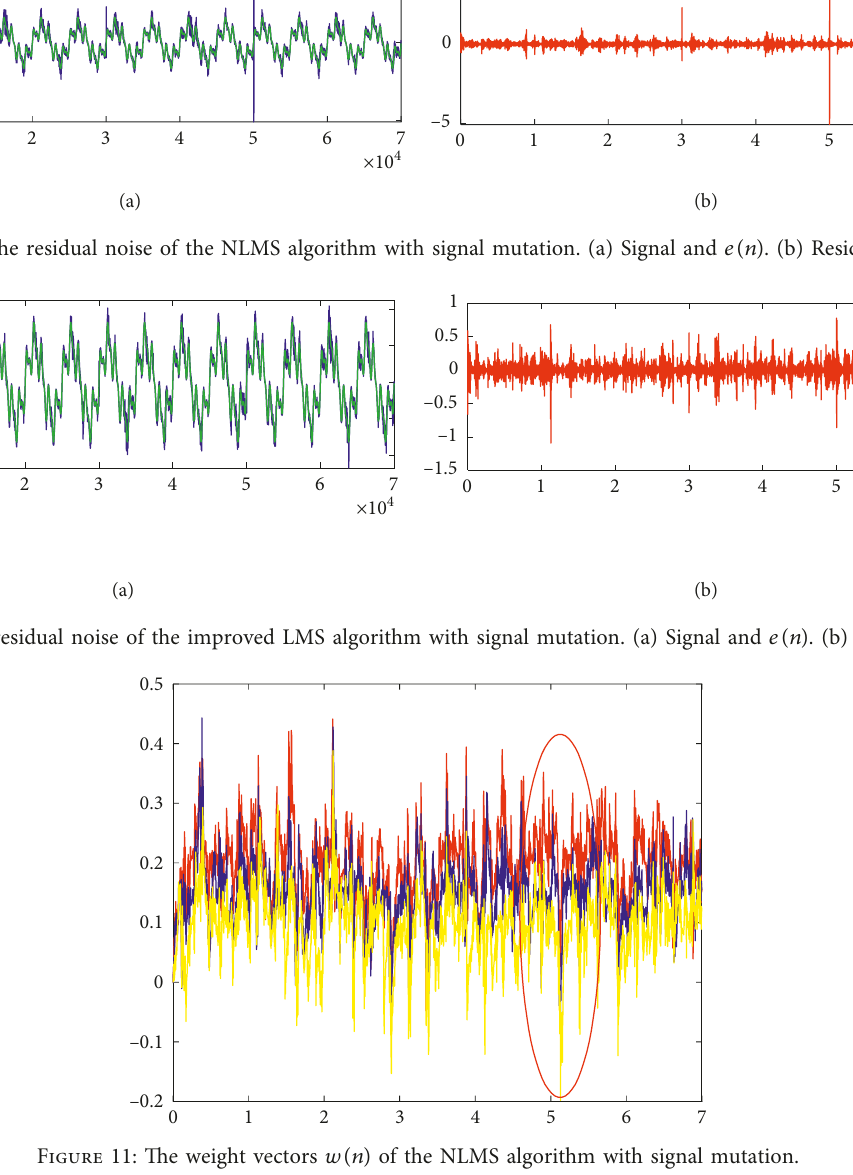
n of the NLMS algorithm with signal mutation. ( )